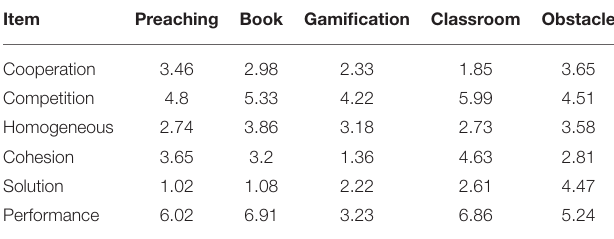
Table 6 , English team learning, as the main carrier of